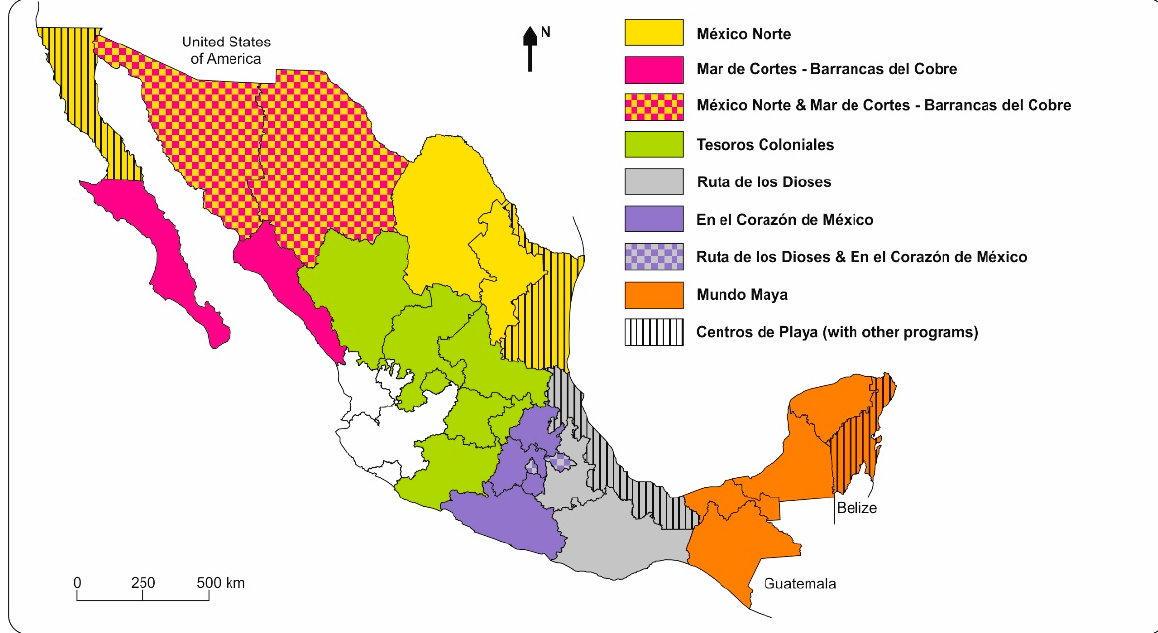
Figure 2. Regional tourism development programs in Mexico. Source: Authors’ own work, based on [61].